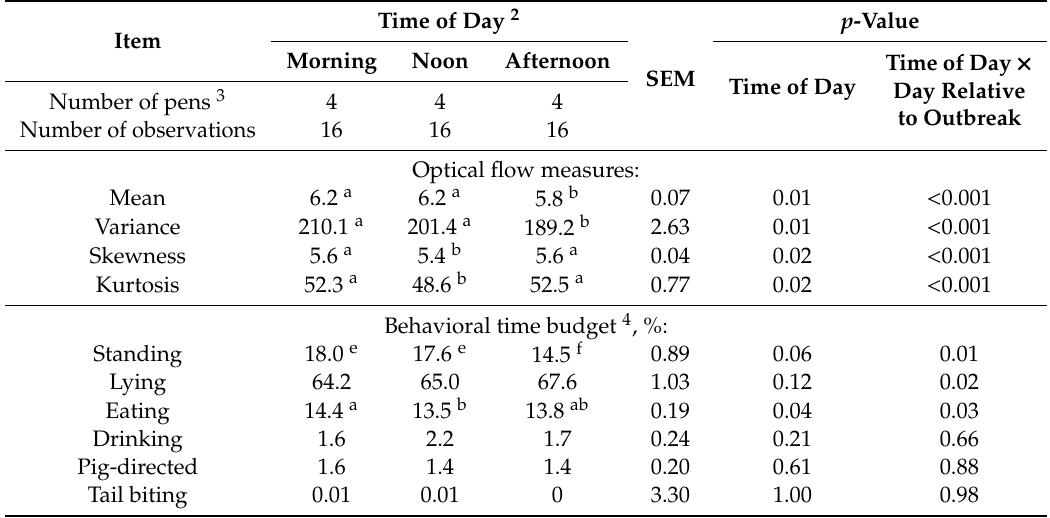
Table 2. Optical flow measures and behavioral time budget during morning, noon, and afternoon for growing-finishing pigs in pens that experienced tail-biting outbreaks during the study period 1. Time of Day